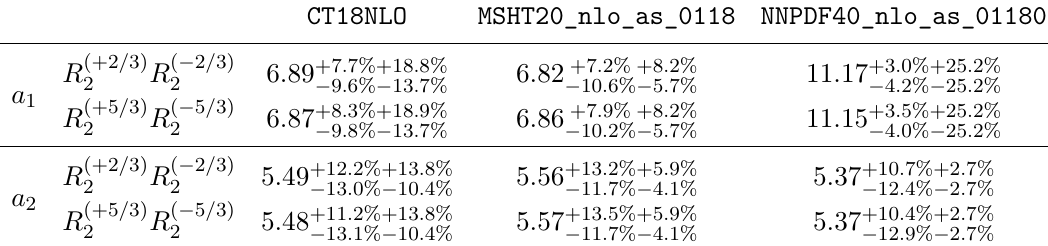
Table 4 . Total cross sections at NLO-QCD (in fb) for the a 1 and a 2 benchmark points of table 1. Our predictions include t -channel contributions, scale uncertainties (first errors reported) and PDF uncertainties (second errors reported). Cross sections below 1 ab are not shown.